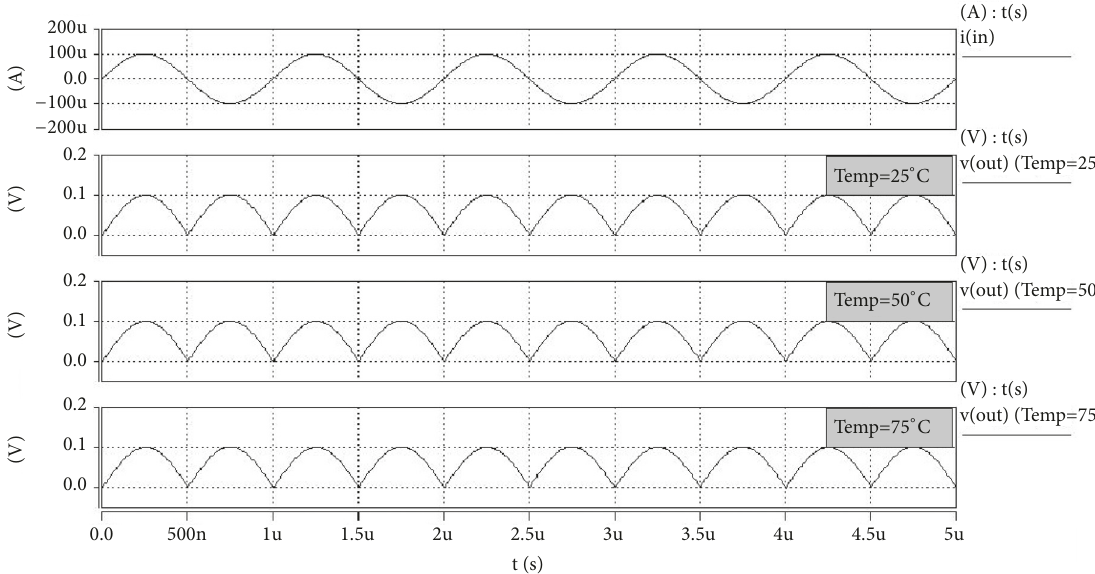
Figure 11: Simulation results of the input and rectified output waveforms of the circuit (Figure 3) under different temperature